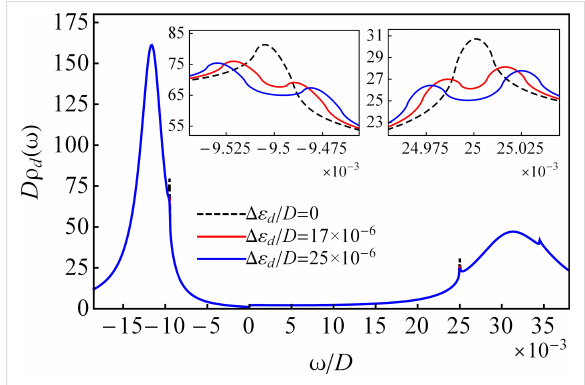
Figure 10: The nonequilibrium DOS in the QD for different values of the Zeeman energy and finite U at temperature T / D = 5 × 10 − 6 . The remaining parameters are the same as those in Figure 9.